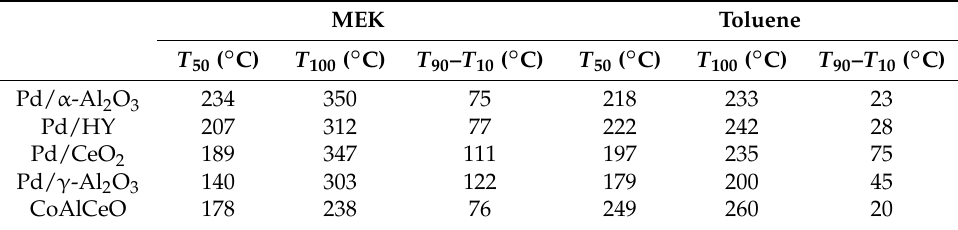
Table 3. Comparison of catalyst performances for the MEK and toluene catalytic